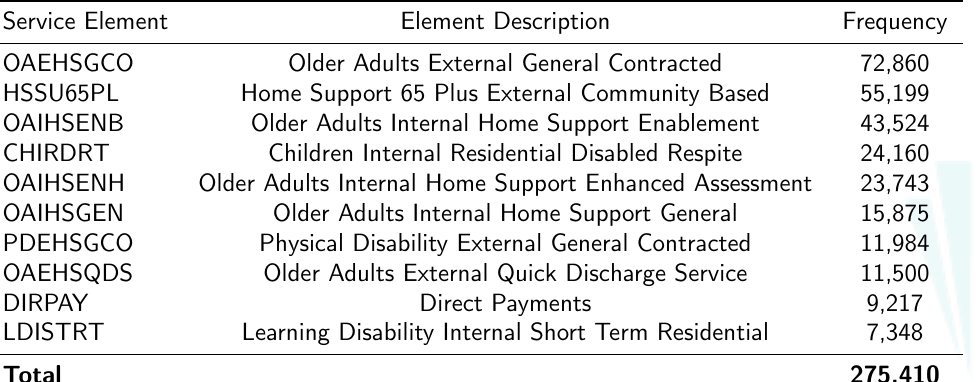
Table 6: Top ten service elements in terms of frequency for the period 2010-2015. Service